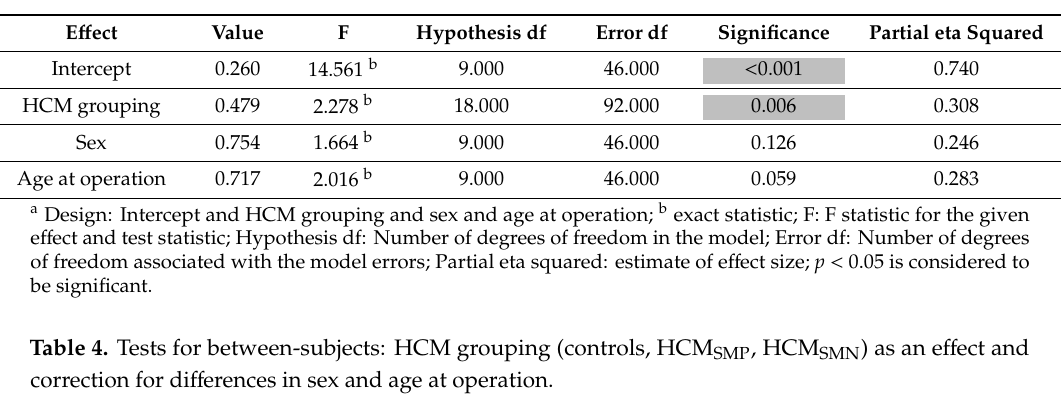
Table 3. Multivariate Tests a : HCM grouping (controls, HCM SMP , and HCM SMN ), sex and age at operation.